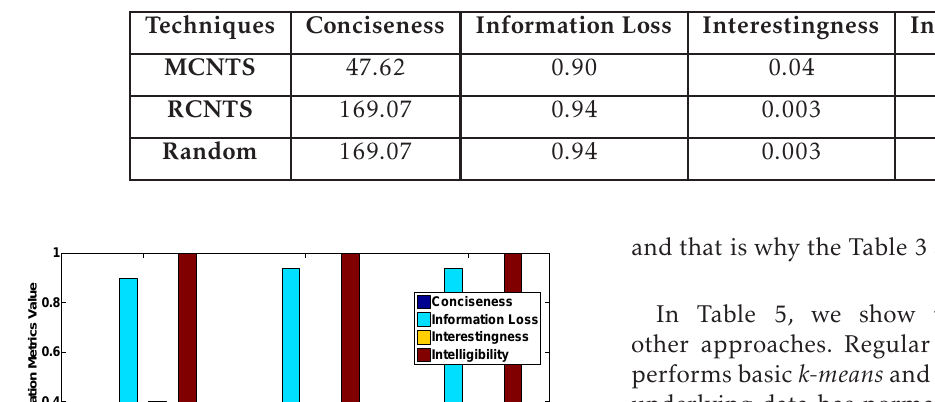
Figure 6. Data distribution of multiview clustering Table 5. Experimental results of the MCNTS algorithm